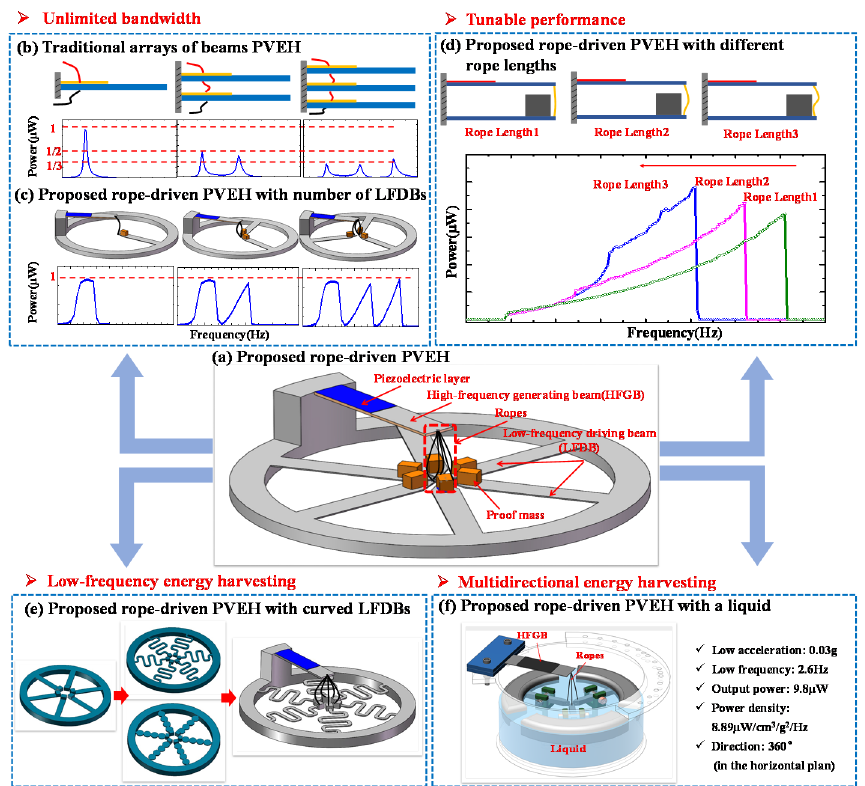
Figure 1. Schematic of the proposed novel low-frequency wideband piezoelectric energy harvester based on rope-driven mechanism for wideband, low-frequency, and multi-directional energy harvesting: ( a ) proposed rope-driven PVEH; ( b ) performance of traditional arrays of beams PVEH vs. number of beams; ( c ) performance of proposed rope-driven PVEH vs. number of LFDBs; ( d ) proposed rope-driven PVEH vs. rope lengths; ( e ) proposed rope-driven PVEH with curved LFDBs; ( f ) proposed rope-driven PVEH using liquid as energy capturing medium.